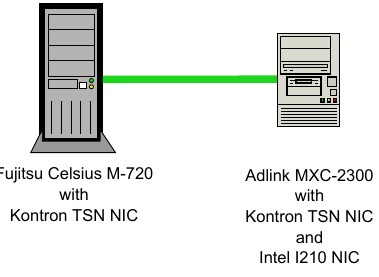
Figure 16. Test setup for the timing